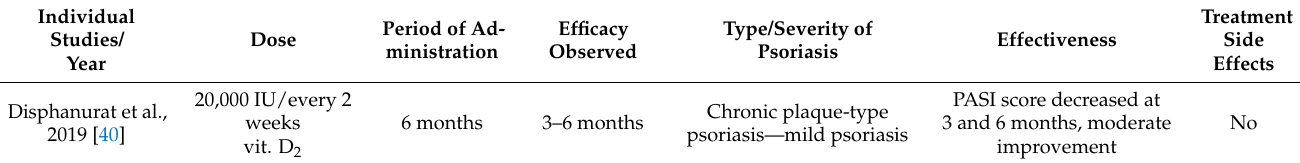
Table 3. Treatment effectiveness of oral vitamin D 2 administered in patients with psoriasis. Individual Studies/